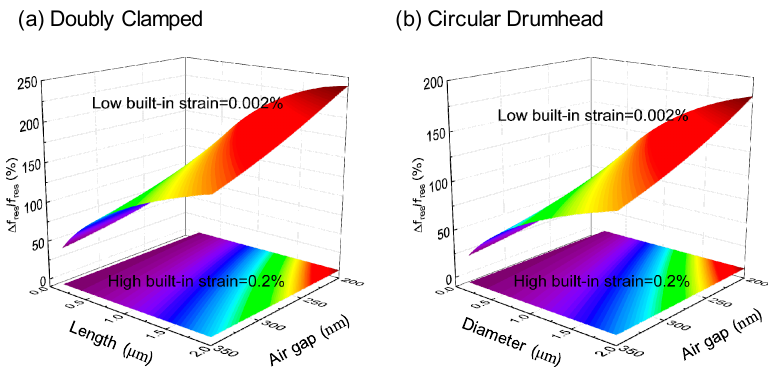
Figure 5. 3D plots of computed frequency tuning with varying characteristic dimension and air gap with high built-in strain (0.2%) and low built-in strain (0.002%). ( a ) Frequency tunability of doubly clamped single-layer (1L) graphene resonators, and ( b ) circular drumhead 1L graphene resonators.